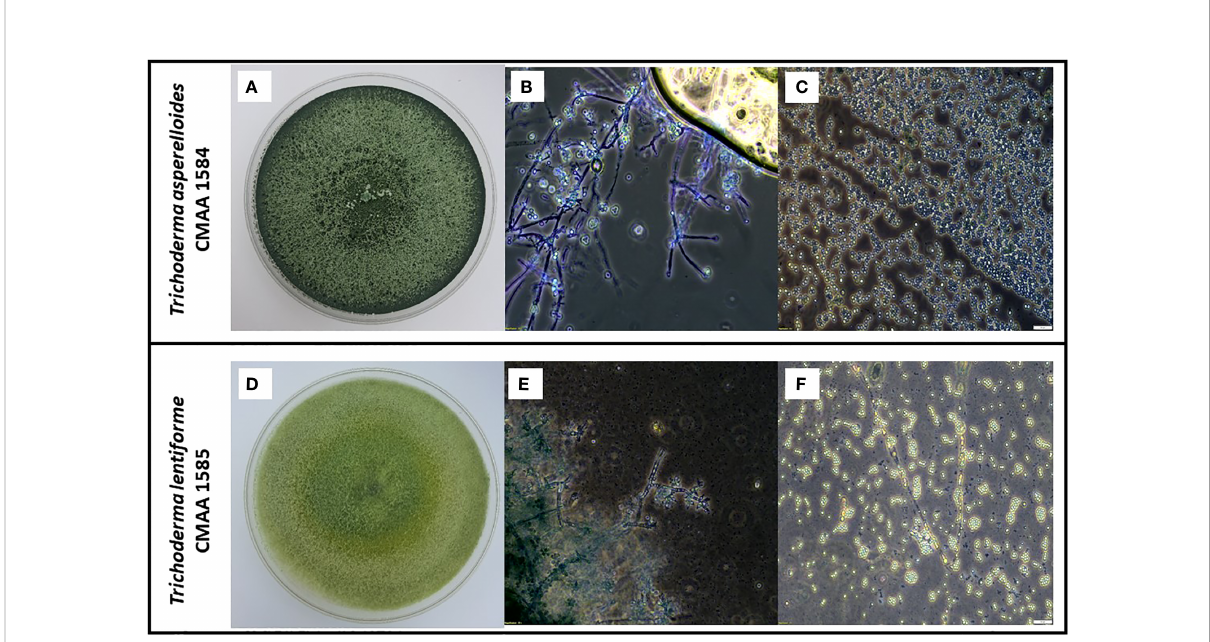
FIGURE 1 Morphological characterization of indigenous Trichoderma asperelloides , and Trichoderma lentiforme strains. (A) Five-day-old PDA-grown cultures of T. asperelloides (CMAA 1584); (B) Microscopic images showing conidiophores of CMAA 1584 (magni fi cation at 200×); (C) Typical conidia of CMAA 1584 (magni fi cation at 200×, scale bar = 20 µm); (D) Five-day-old PDA-grown cultures of T. lentiforme (CMAA 1585); (E) Microscopic images showing conidiophores of CMAA 1585 (magni fi cation at 200×); (F) Typical conidia of CMAA 1585 (magni fi cation at 200×, scale bar = 20